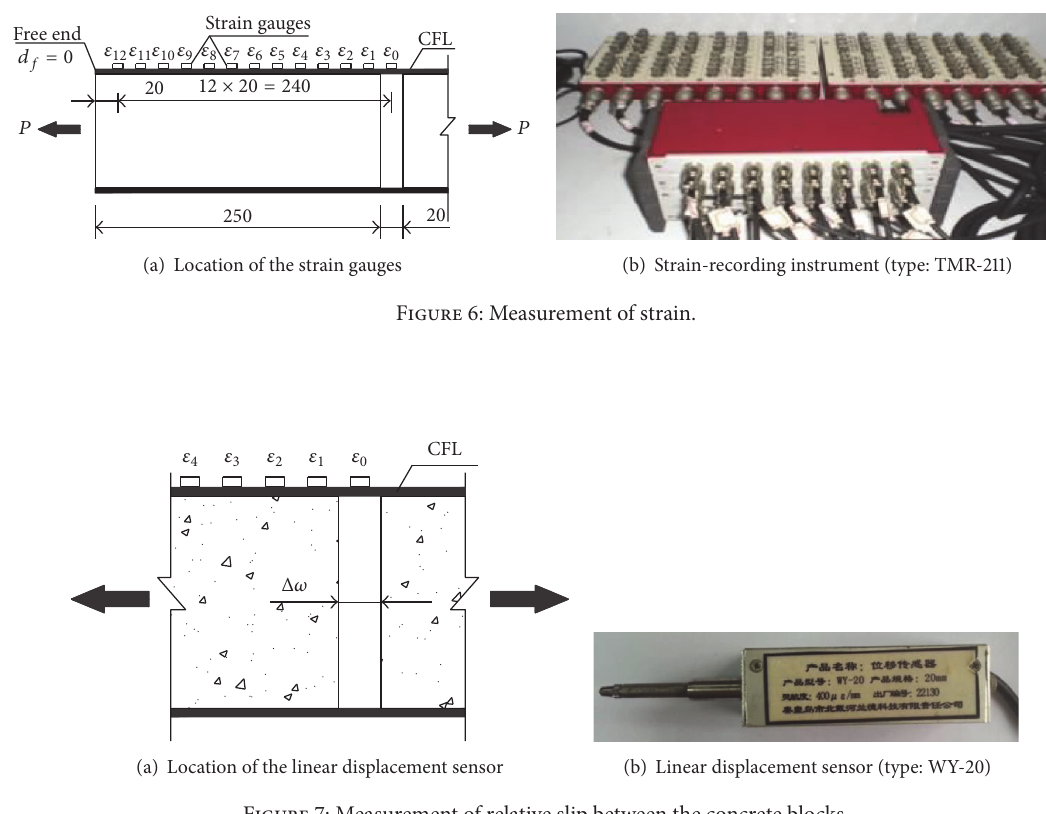
Figure 7: Measurement of relative slip between the concrete blocks.